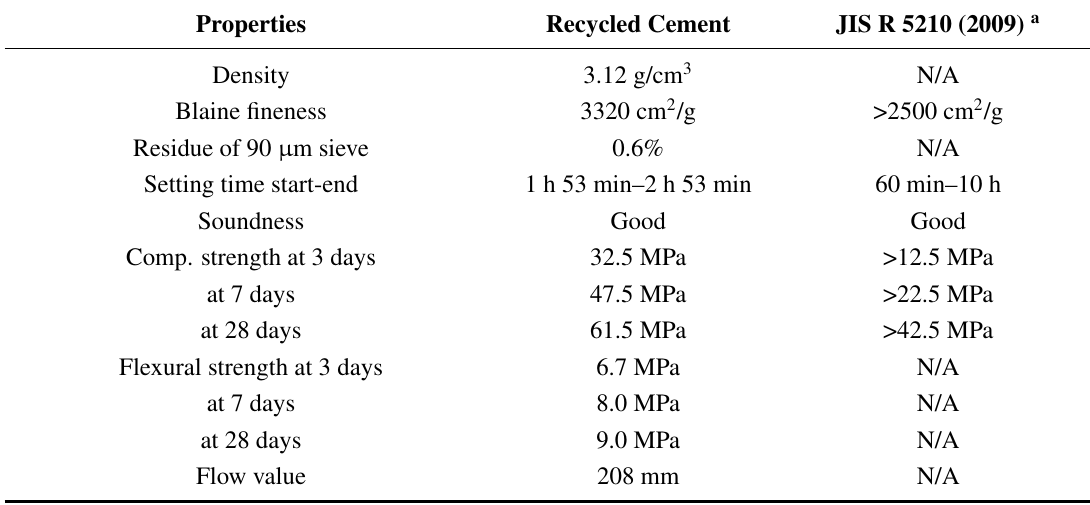
Table 9. Physical properties of the recycled